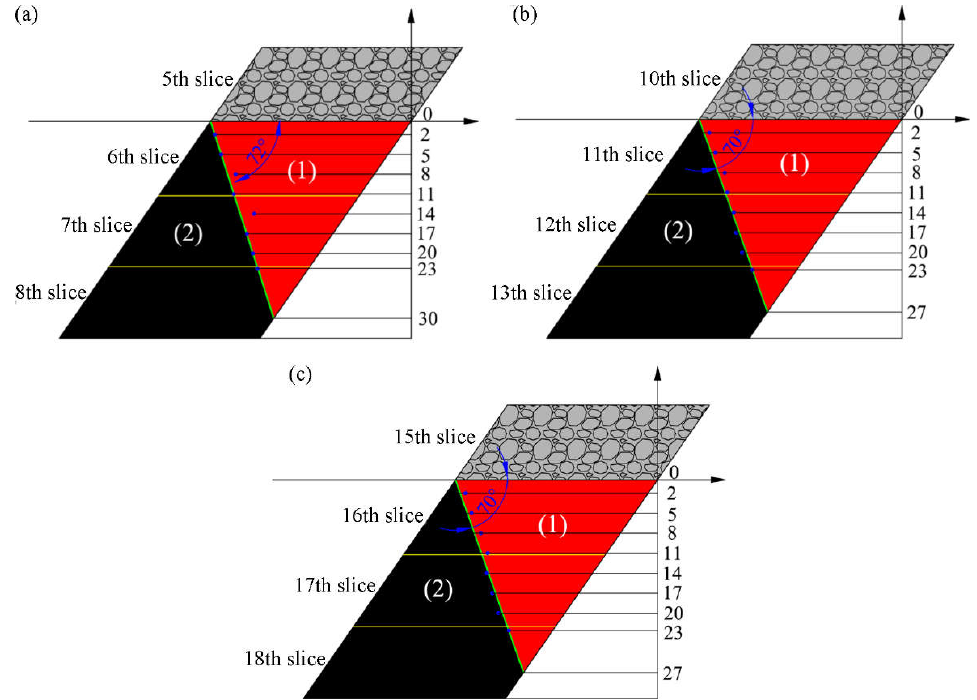
Figure 8. Pressure relief range in the coal below the goaf: ( a ) the 5th slice, ( b ) the 10th slice and ( c ) the 15th slice. In each figure, (1) denotes the pressure relief zone, and (2) denotes the stress concentration zone.